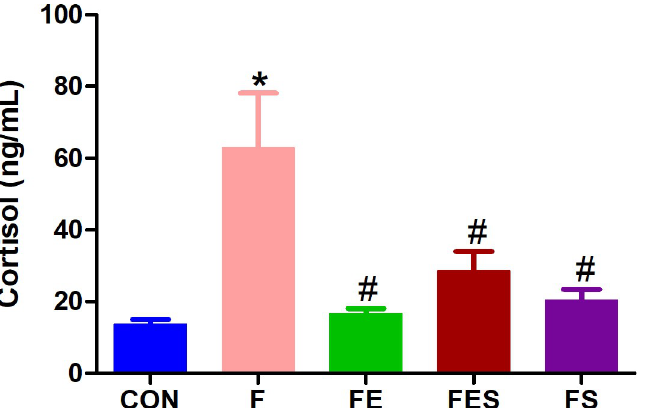
Fig 2. Serum cortisol concentrations. CON, control; F, fibromyalgia induced; FE, fibromyalgia induced plus exercise; FES, fibromyalgia induced plus exercise and TRP supplementation; FS, fibromyalgia induced plus TRP supplementation. Data are means ± SD from 6 to 8 animals in each group. � p < 0.05 vs CON group. # p < 0.05 vs F group (ANOVA one-way followed by Tukey’s post hoc test). mechanical hyperalgesia) to control levels at weeks 1 (~ 162%), 2 (~ 157%) and 3 (~ 151%),